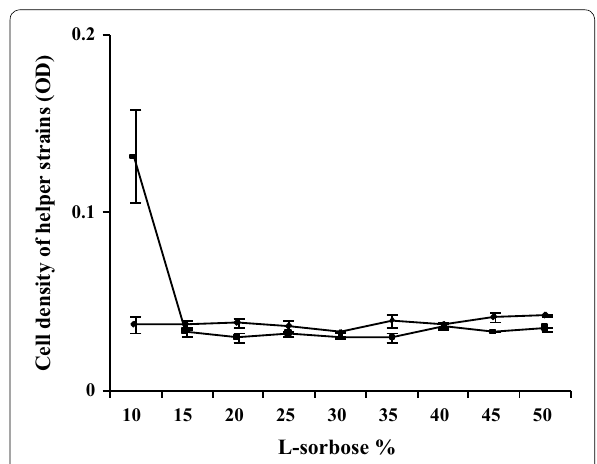
Fig. 1 The effect of l -sorbose on the growth of helper strain. Diamond the OD of helper strain at 0 h of fermentation at different concentration of l -sorbose; square the OD of helper strain at 12 h of fermentation at different concentration of l